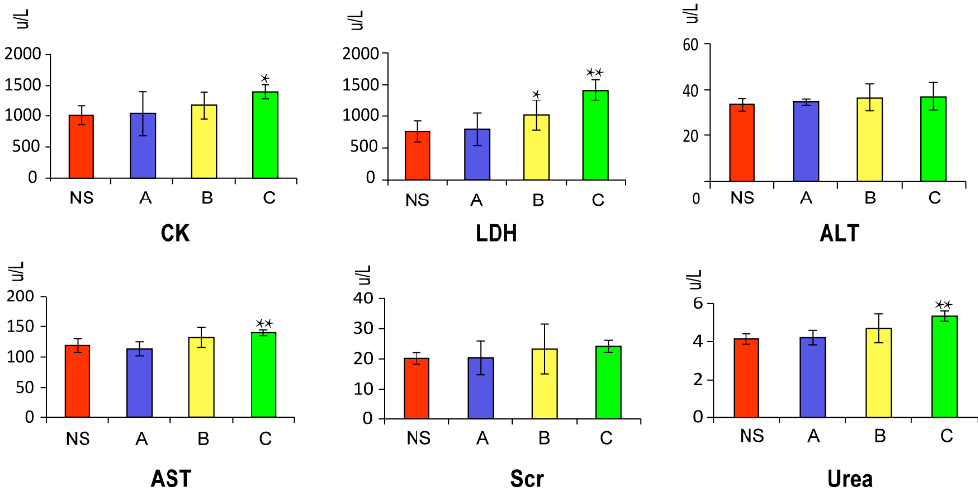
Figure 1. Effect of different concentrations of Radix Aconiti ethanol extract groups on various biochemical parameters in rats. Significant difference from control: * p < 0.05, ** p < 0.01. NS: Normal Saline; A: 2 g/kg ethanol extraction; B: 5 g/kg ethanol extraction; C: 10 g/kg ethanol extraction.